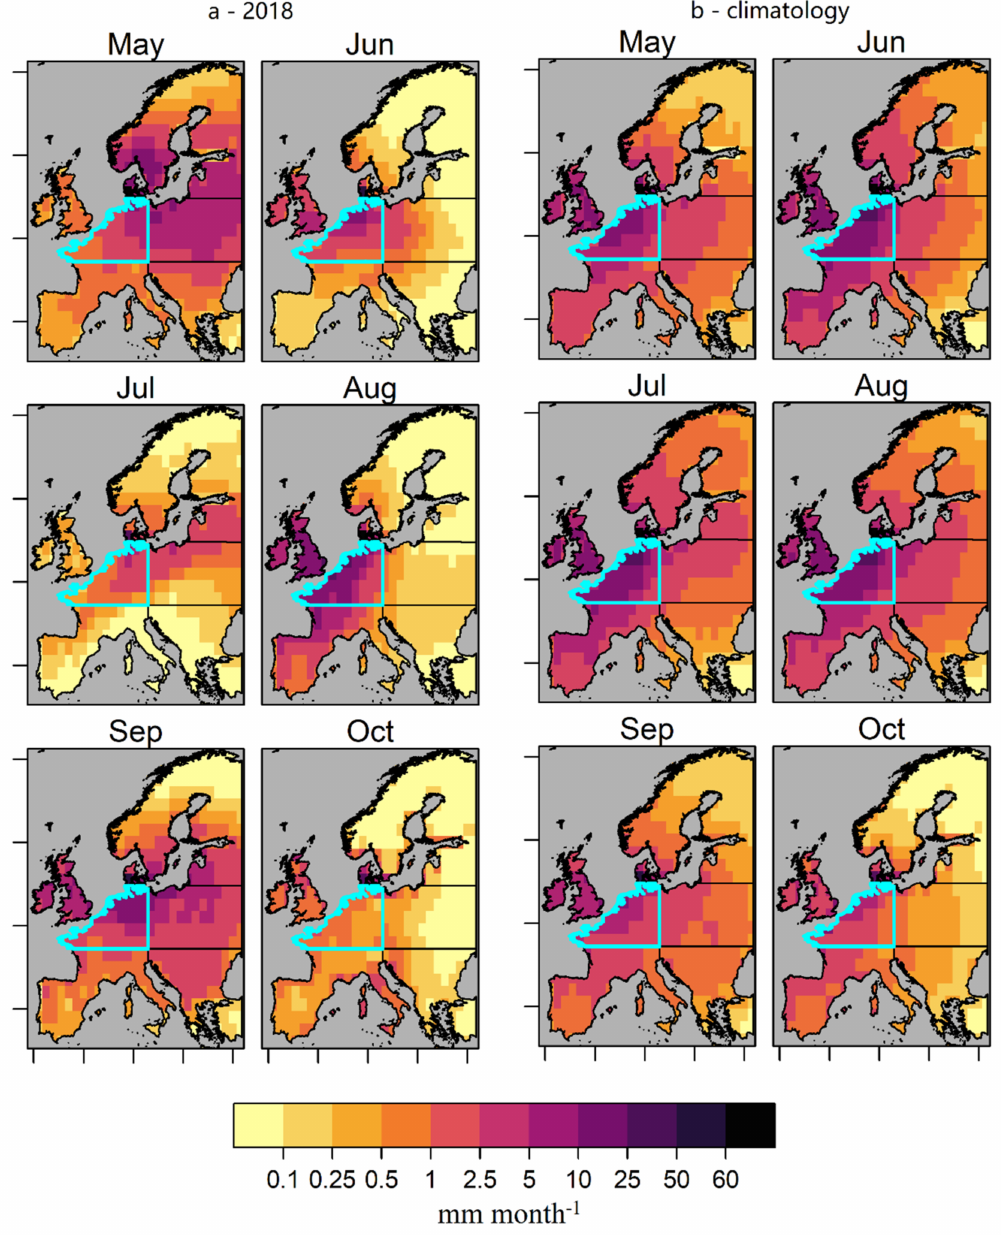
Figure 7. ( a ) Monthly land evaporation emerging from source regions and falling in sink region 3 in 2018 (west of Europe). ( b ) The climatology monthly land evaporation emerging from source regions and falling in sink region 3 (cyan